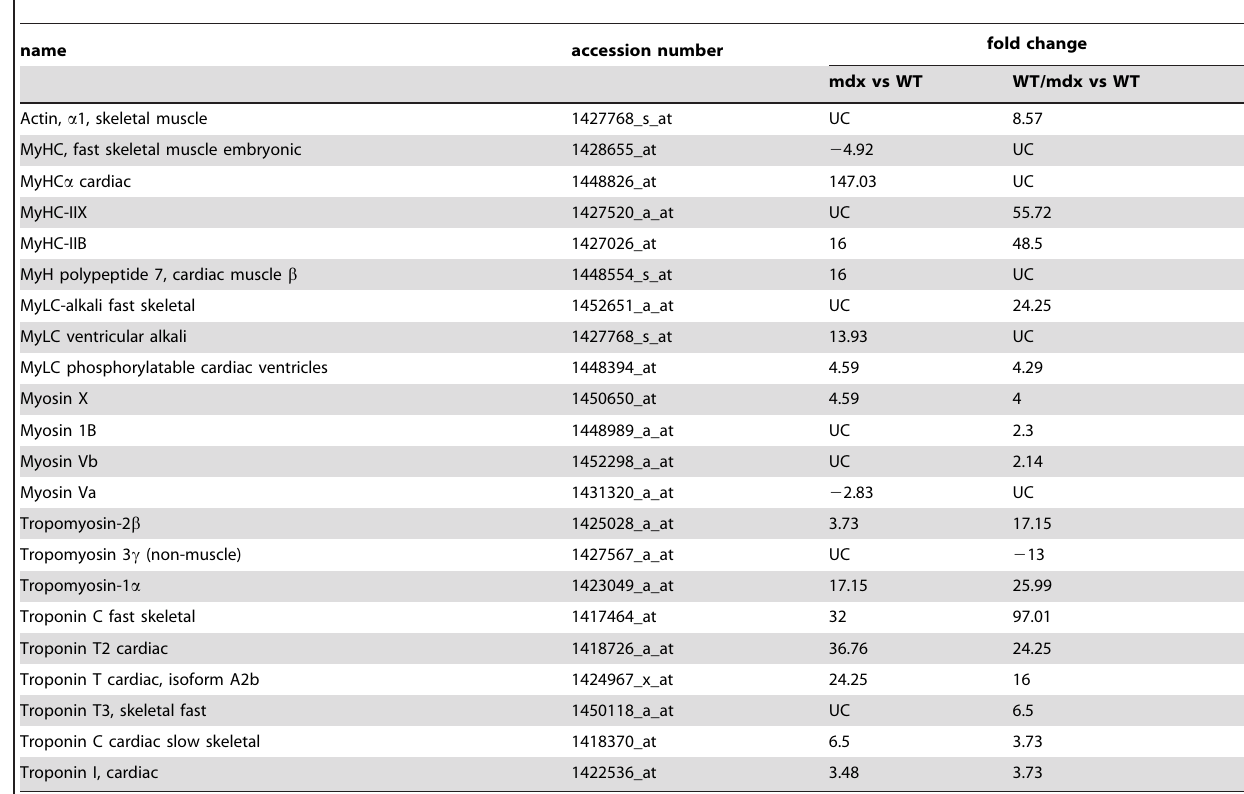
Table 3. Cardiac and skeletal muscle contractile markers are upregulated in mdx and WT/mdx adipose